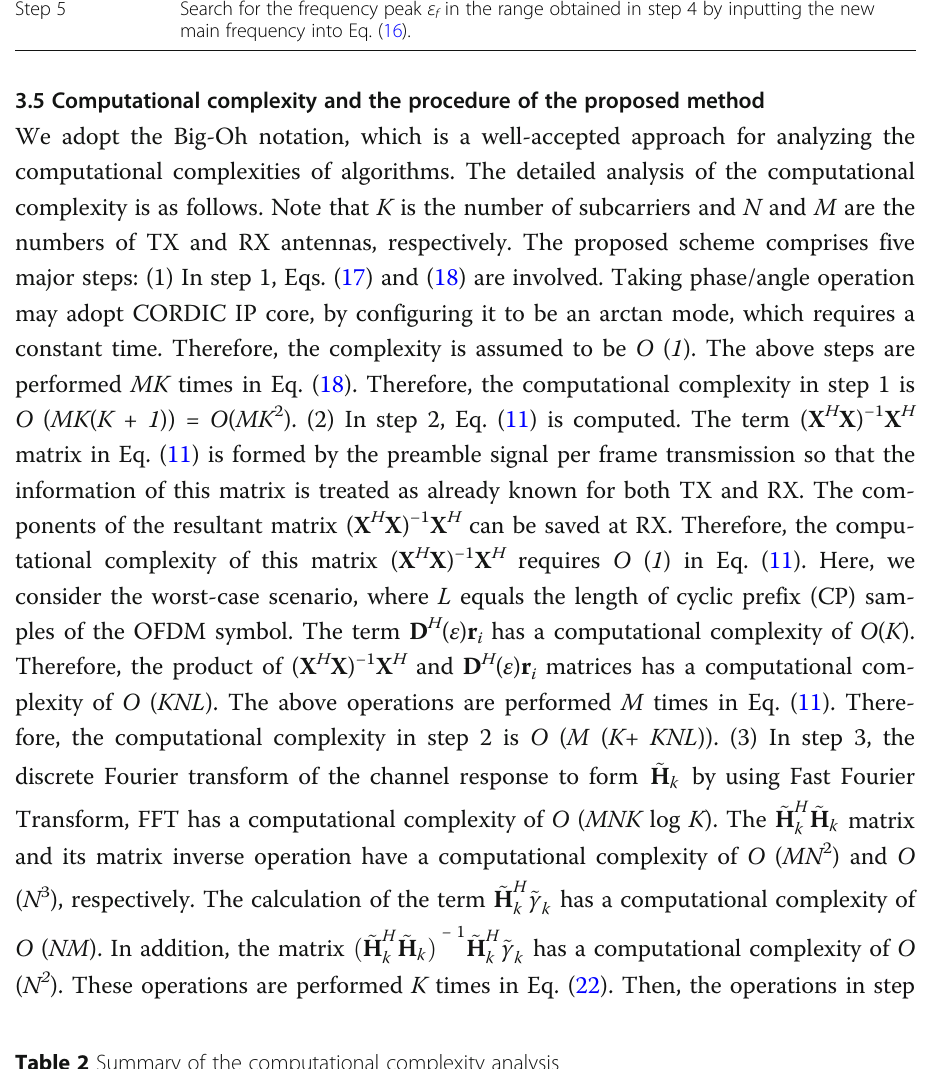
Table 2 Summary of the computational complexity analysis